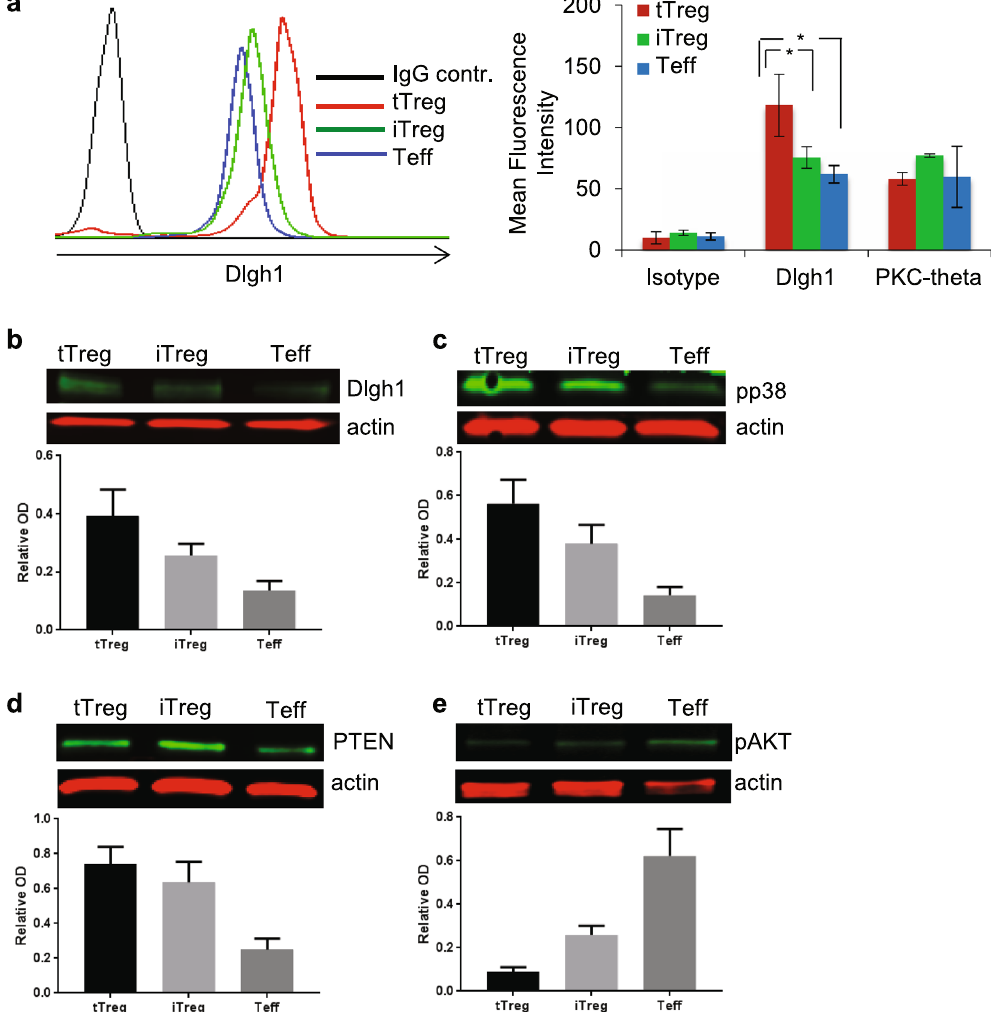
Figure 3. Intracellular levels of Dlgh1 and PKC- θ were determined by intracellular staining by FACS ( a ) or by Western Blot ( b ) in tTregs, iTregs and Teffs. Cells were activated by immobilized anti-CD3 antibodies (5 μ g/ ml) and lysed. Phosphorylation of p38 ( c ) and AKT ( d ) as well as PTEN protein levels ( e ) was determined by Western Blot. Data are representative of 3 different experiments, the bar charts (B-E) are means ± SEM. * P < 0.05 was calculated by t test. Full-length gels are included in Supplementary Figure